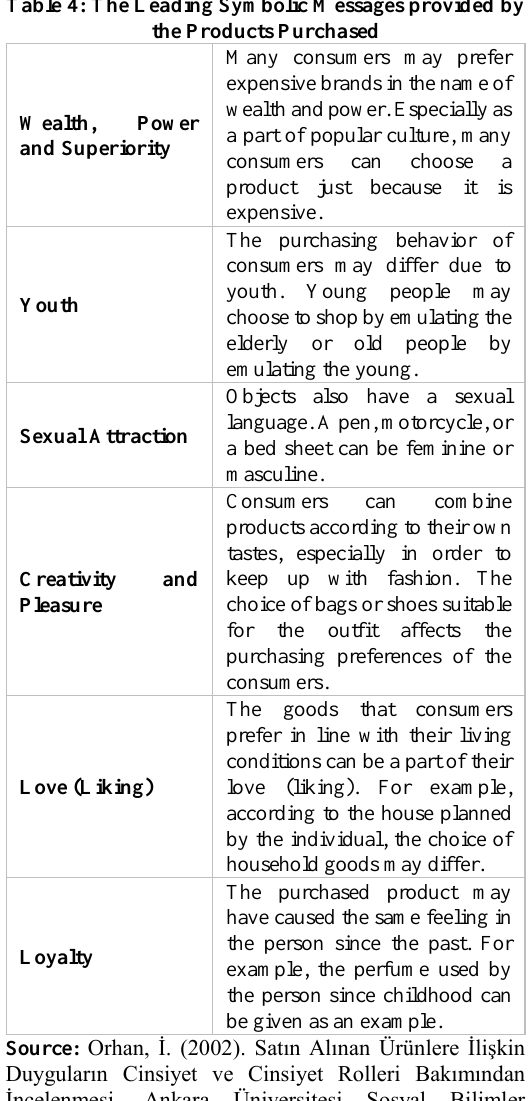
Table 4: The Leading Symbolic Messages provided